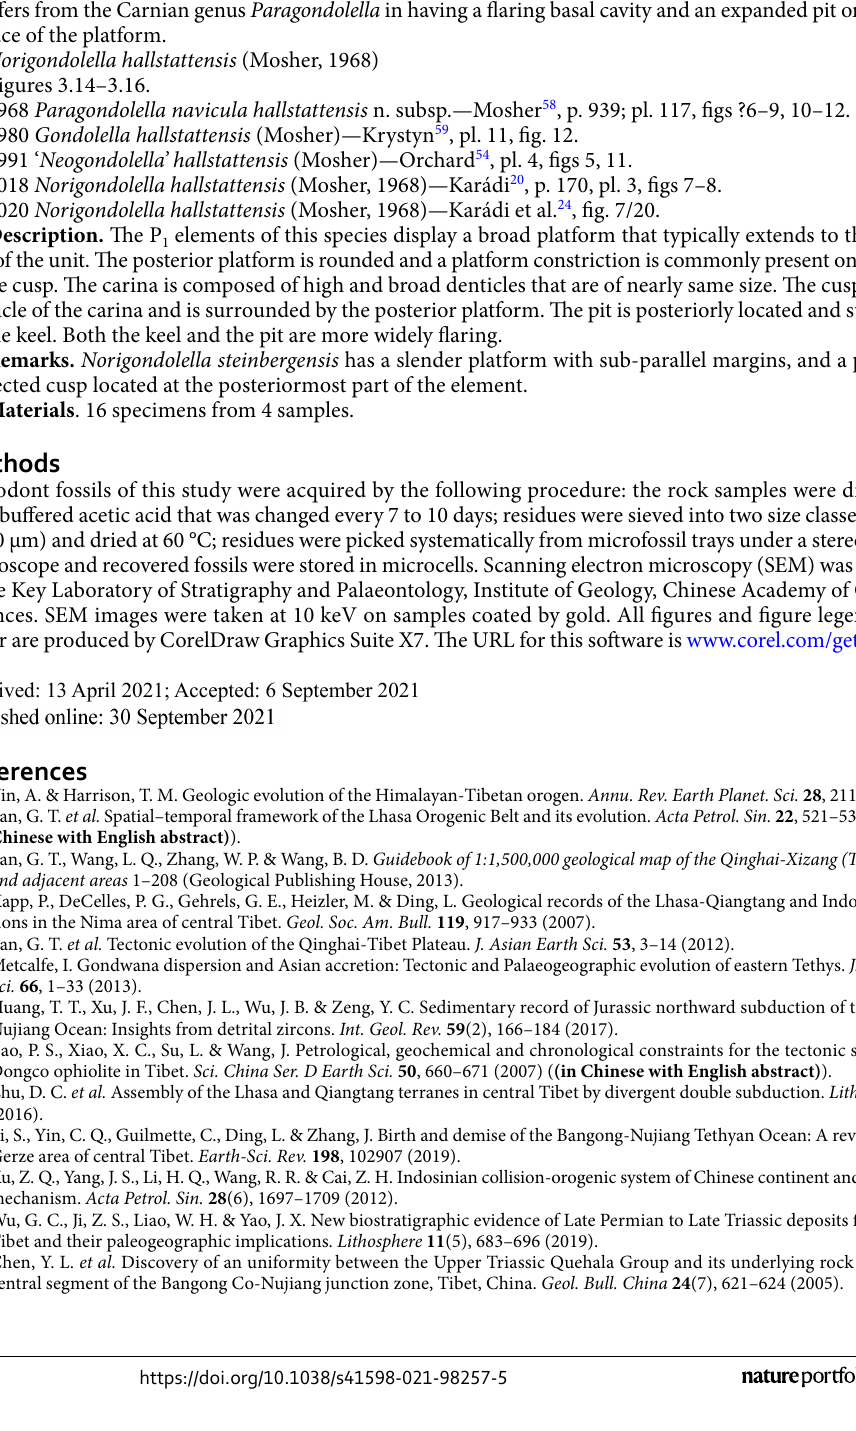
Figure 3.11. Remarks. The present specimens differ from most other Early Norian species by the presence of a broad round posterior platform with a length-to-breadth ratio of 1:1. The platform is widest close to the posterior margin, anteriorly it decreases rapidly. There are two to three large denticles on each side of the anterior platform margin. The posterior half of platform margin is flat and unornate. The centrally located small cusp is followed by a large denticle that ends the carina. There is a wide posterior platform brim. On the lower surface, the keel is slightly bifurcated posterior to the centrally located pit. Materials. 5 specimens from 1